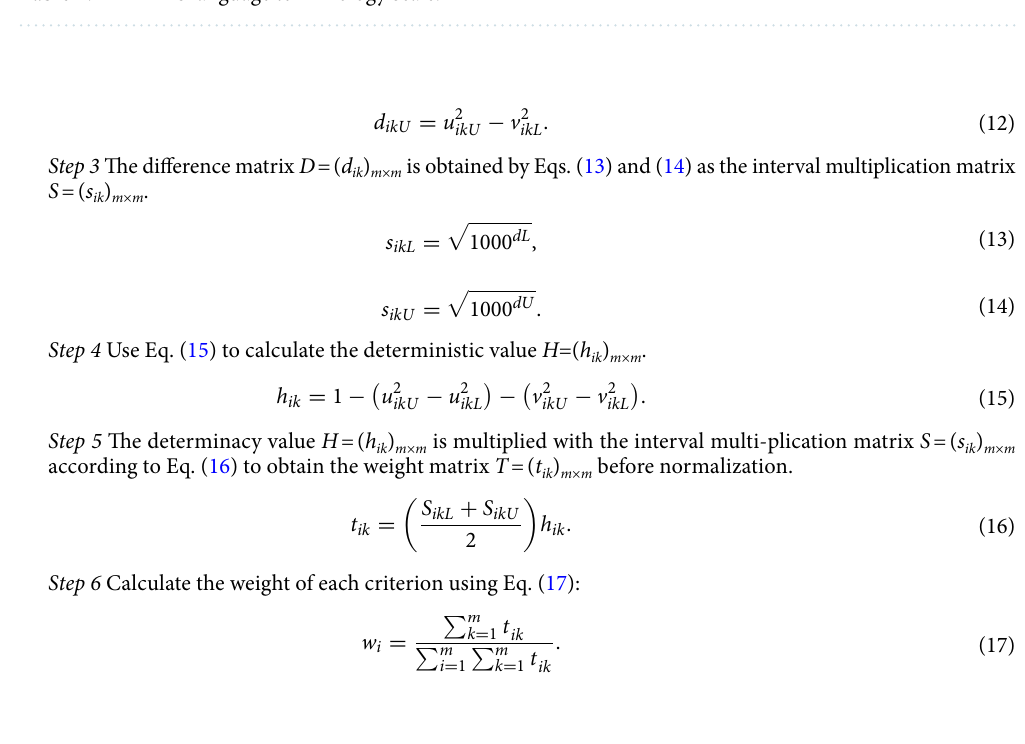
Table 2. PFAHP’s language terminology